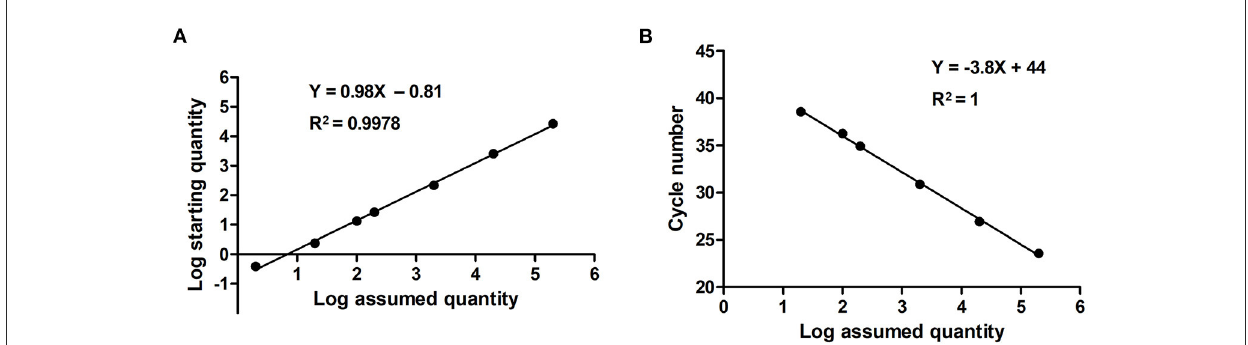
FIGURE3 Quantification of serially diluted PoRVA plasmids by ddPCR and qPCR. (A) Standard curves PoRVA plasmids constructed by ddPCR. The quantification correlation was obtained by plotting the log assumed concentration against the log starting concentration. (B) Standard curves of PoRVA plasmids constructed by qPCR. The quantification correlation was obtained by plotting the quantification cycle value against the log starting concentration.